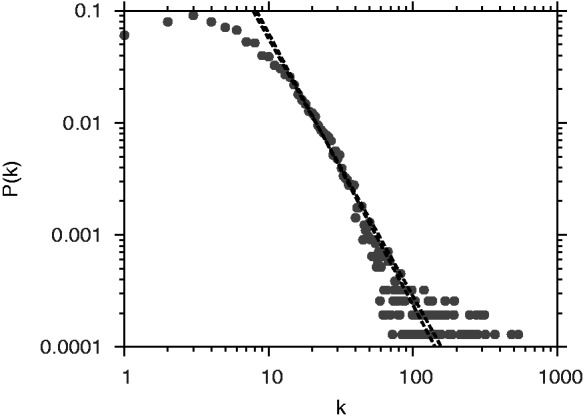
Scale-free nature of the Arabidopsis whole-genome network. Node degree distribution in the network. X-axis is the node degree and Y-axis represents the probability of a node with a given degree.